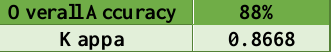
Table 3. Results of final fusion